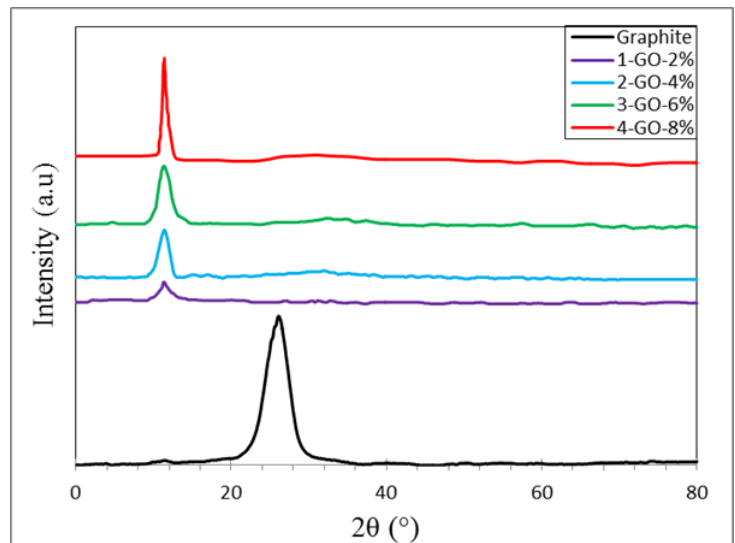
Fig.1: X-ray diffraction spectra of graphite powder and graphene oxide thin films.